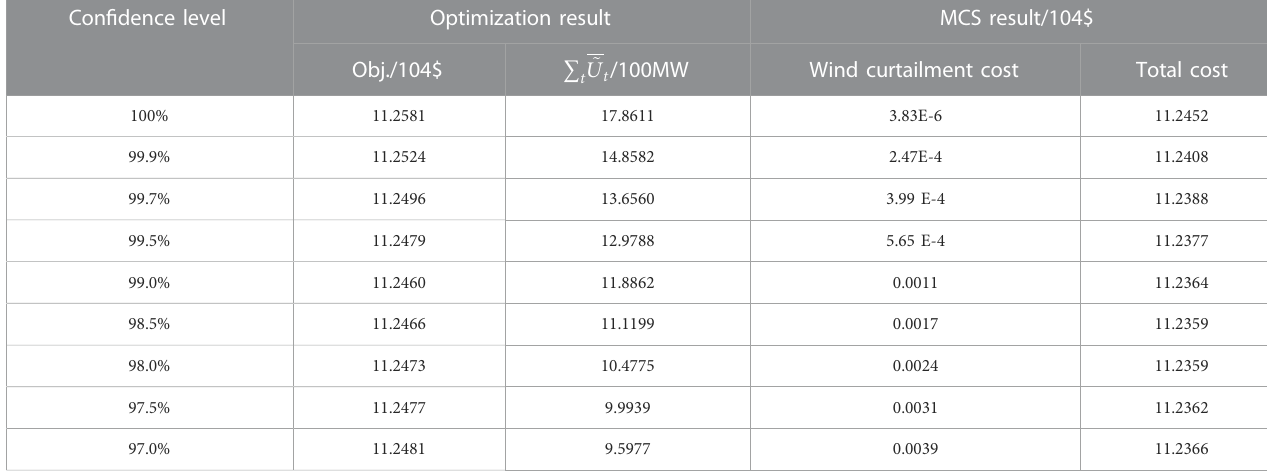
TABLE 5 Optimization and MCS results with different con fi dence